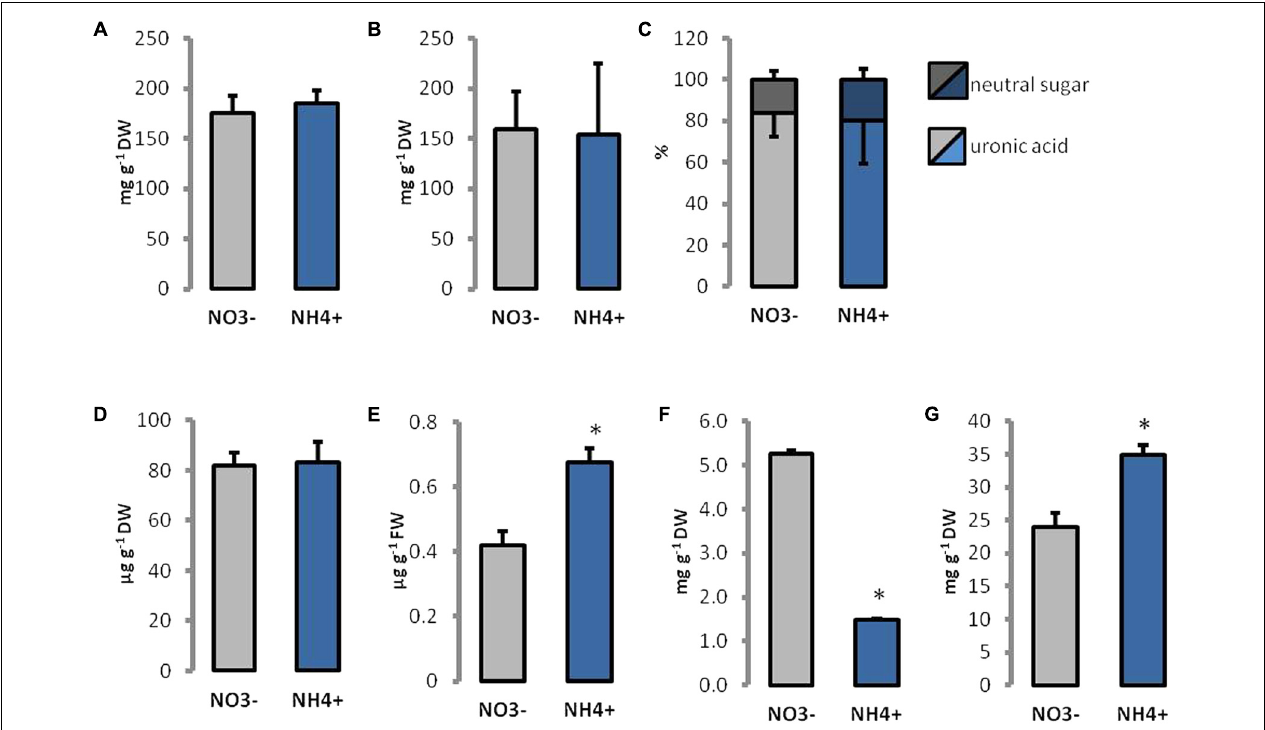
FIGURE 4 | Content of major polysaccharides and other components in cell wall constituents isolated from leaves of plants growing on NH 4 + and NO 3 − (control) as the only N source. (A) Cellulose and (B) pectin levels were measured in dried cell walls. (C) The proportion of uronic acids and neutral sugars in the pectin-enriched fraction. The content of (D) lignin and (E) phenolics isolated from cell walls. (F) The content of calcium and (G) boron ions in leaf